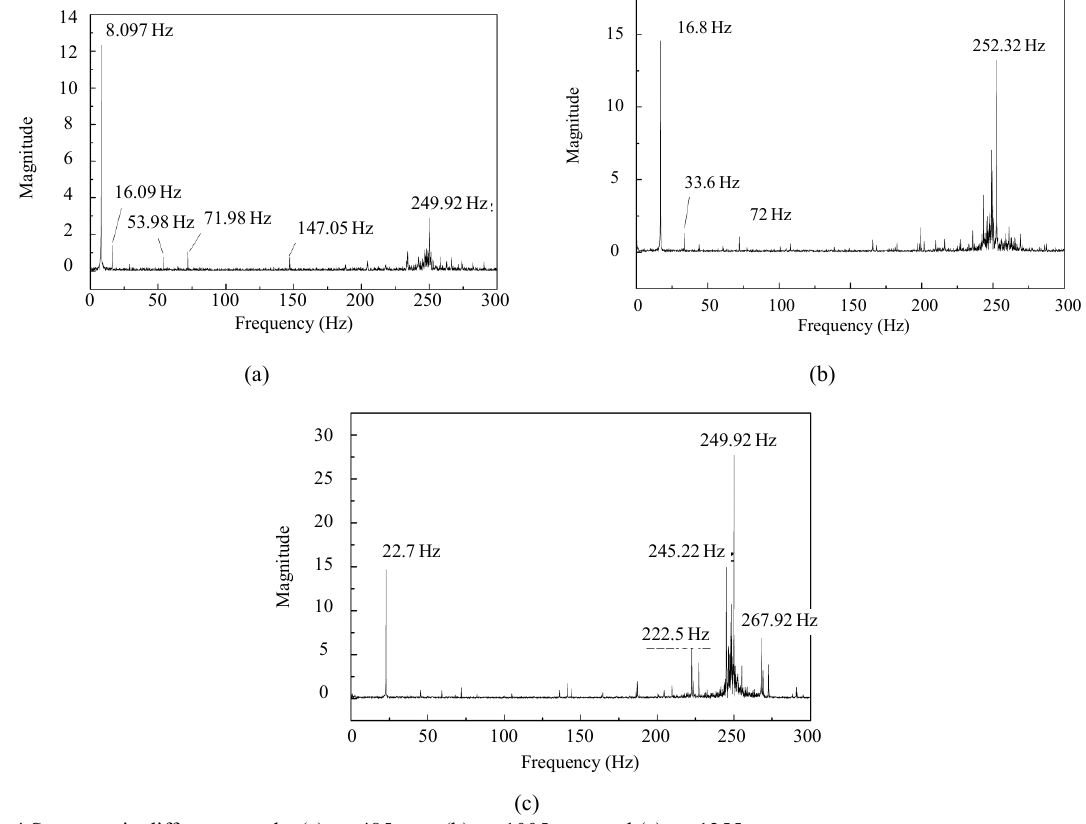
Fig. 4 Spectrum in different speeds: (a) v = 485 rpm, (b) v = 1005 rpm, and (c) v = 1355